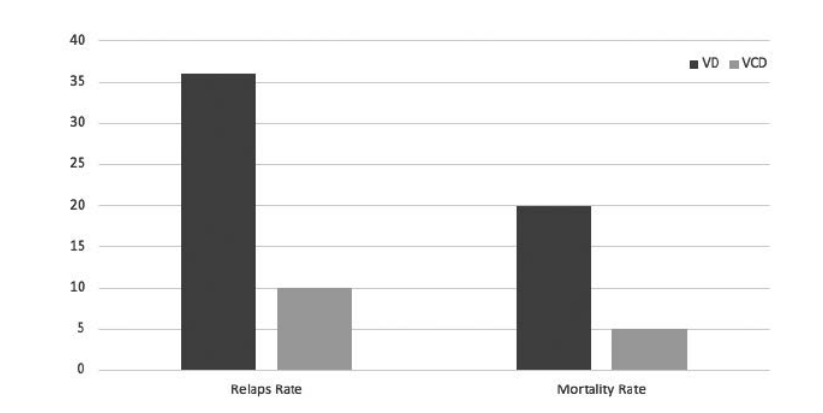
Figure 2. Relapse rate (P=0.002) and mortality rate (p=0.01) for VD and VCD